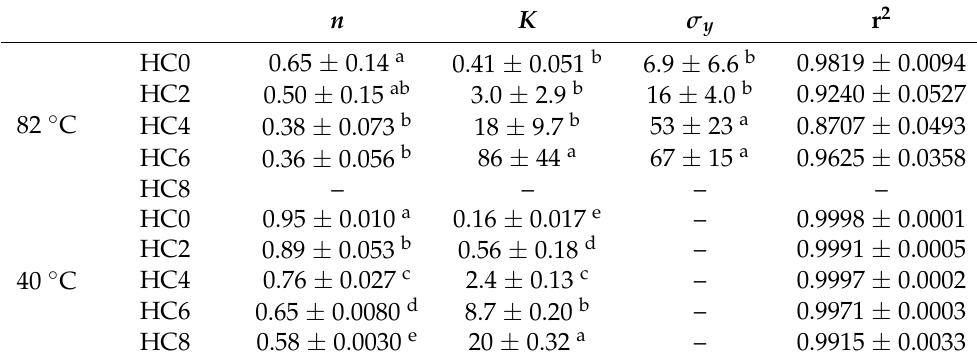
Table 2. Flow behavior index ( n ), fluid consistency index ( K ), yield stress ( σ y ), and regression coefficient (r 2 ) of HPMC/CL blends at 82 ◦ C and 40 ◦ C,